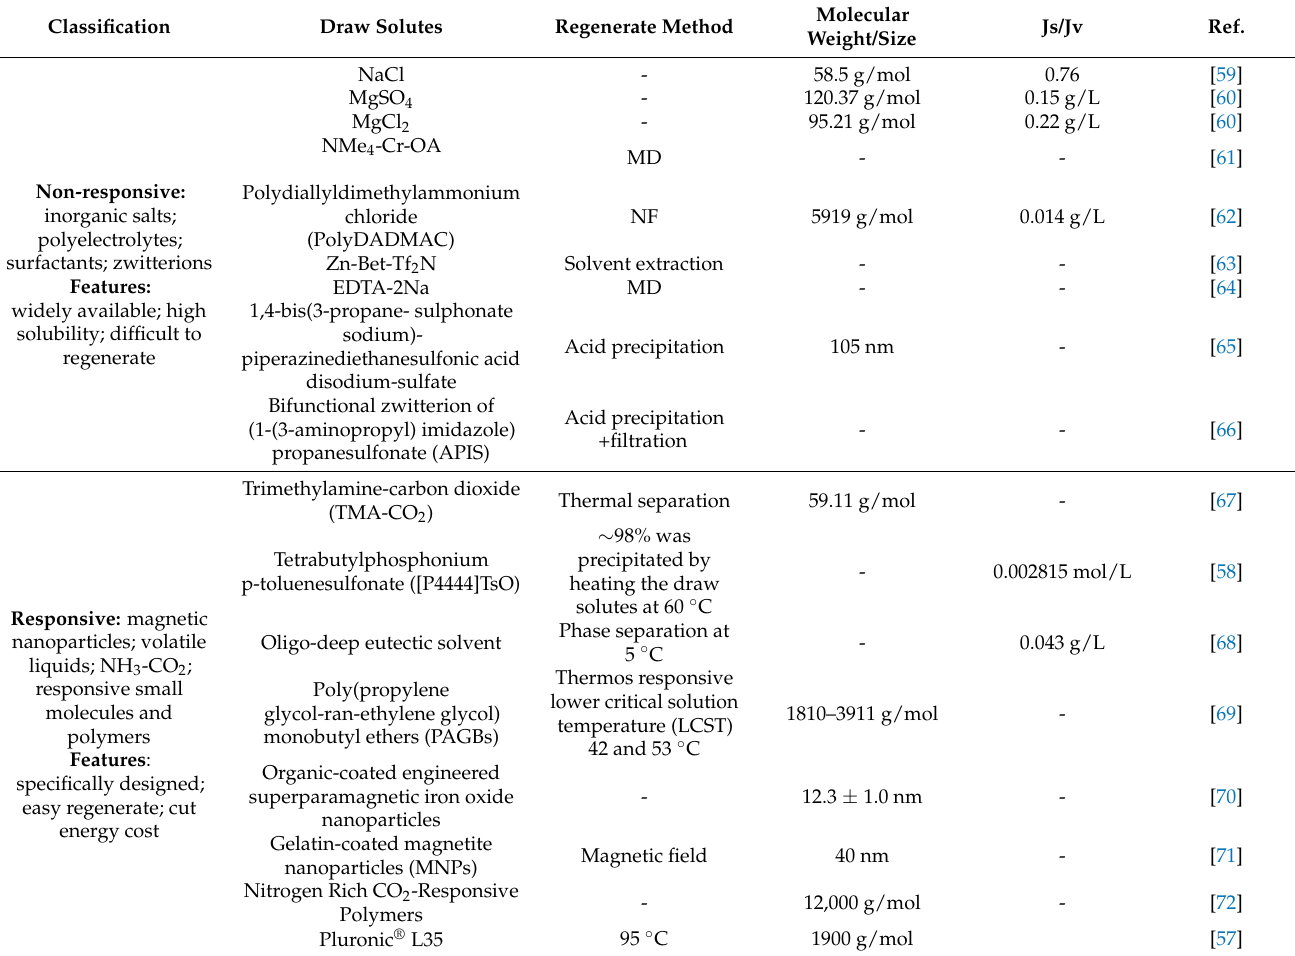
Table 1. Review of the representative draw solutes in the FO